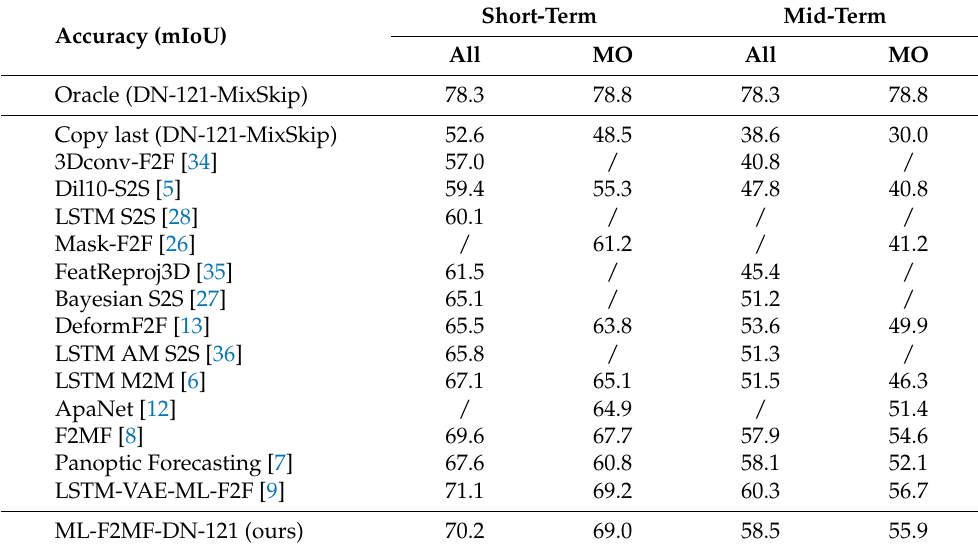
Table 4. Evaluation of short-term and mid-term forecasting accuracy (mIoU) on Cityscapes val. All denotes all classes; MO denotes moving